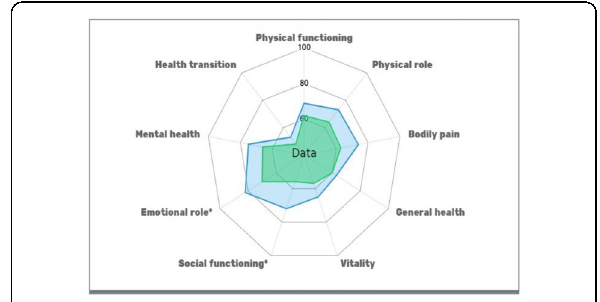
Fig. 1 (abstract 001601). Radar plot for SF-36 domain scores by presence/absence of delirium in critically ill